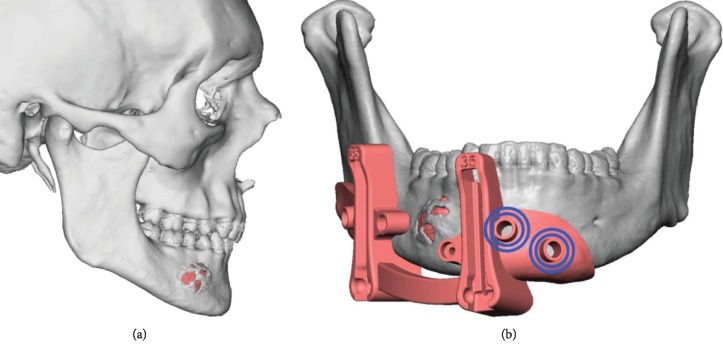
Preoperative operative 3D image of tumor involving the mandible. (a) Lateral view. (b) Frontal view: showing cutting guide and planned resection.